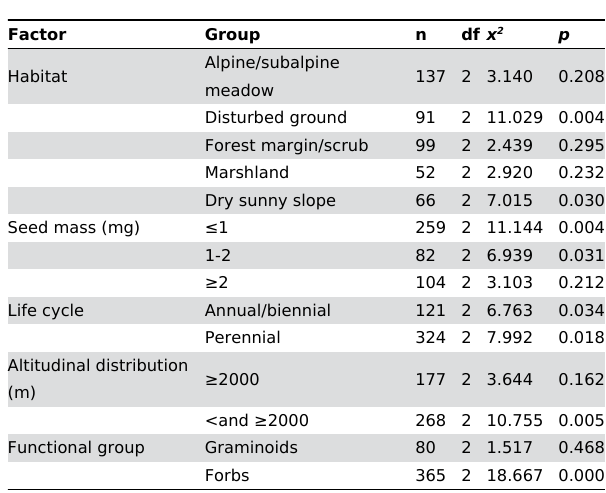
Table 1. Germination responses of species that differ in habitat, seed mass, life cycle type, altitudinal distribution and functional